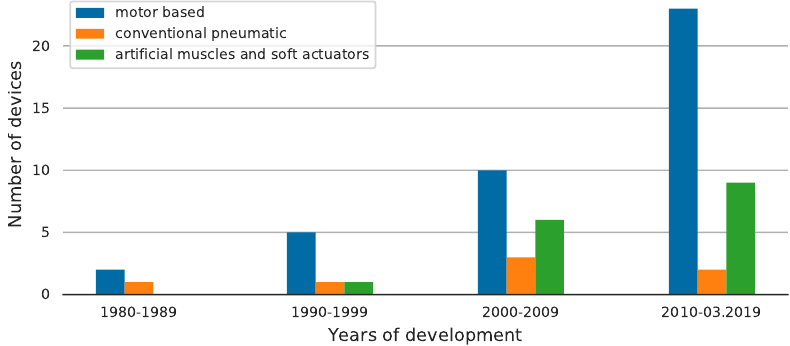
Figure 5. Application timeline of different types of